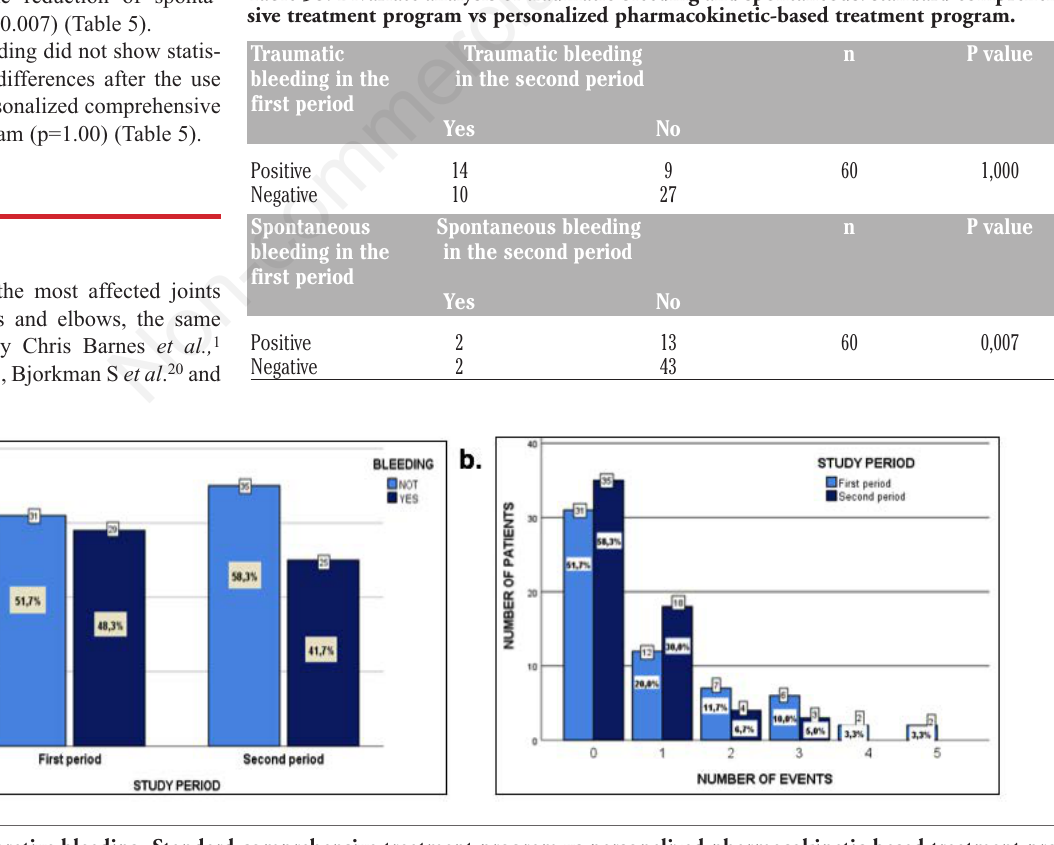
Figure 1. a. Comparative bleeding: Standard comprehensive treatment program vs personalized pharmacokinetic-based treatment pro- gram. b. Comparative bleeding events: Standard comprehensive treatment program vs personalized pharmacokinetic-based treatment program.